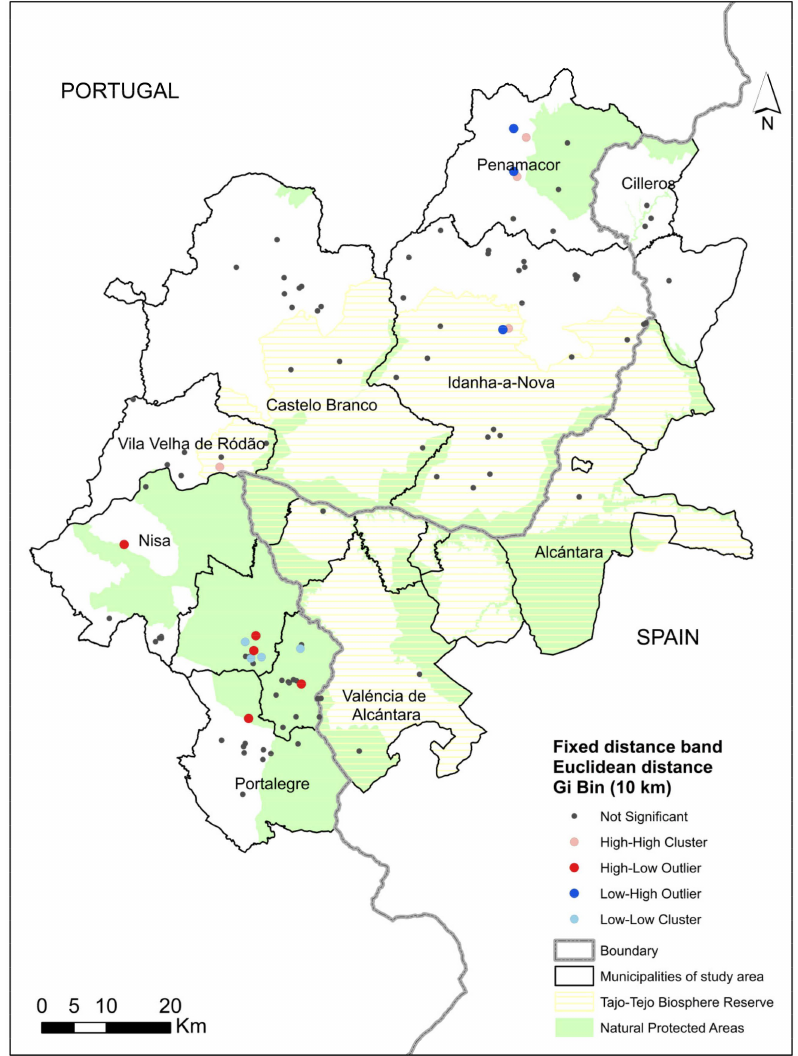
Figure 8. The results of the cluster and outlier analysis of global sustainability indicators. Source: authors’ own material from calculations carried out with ArcGis